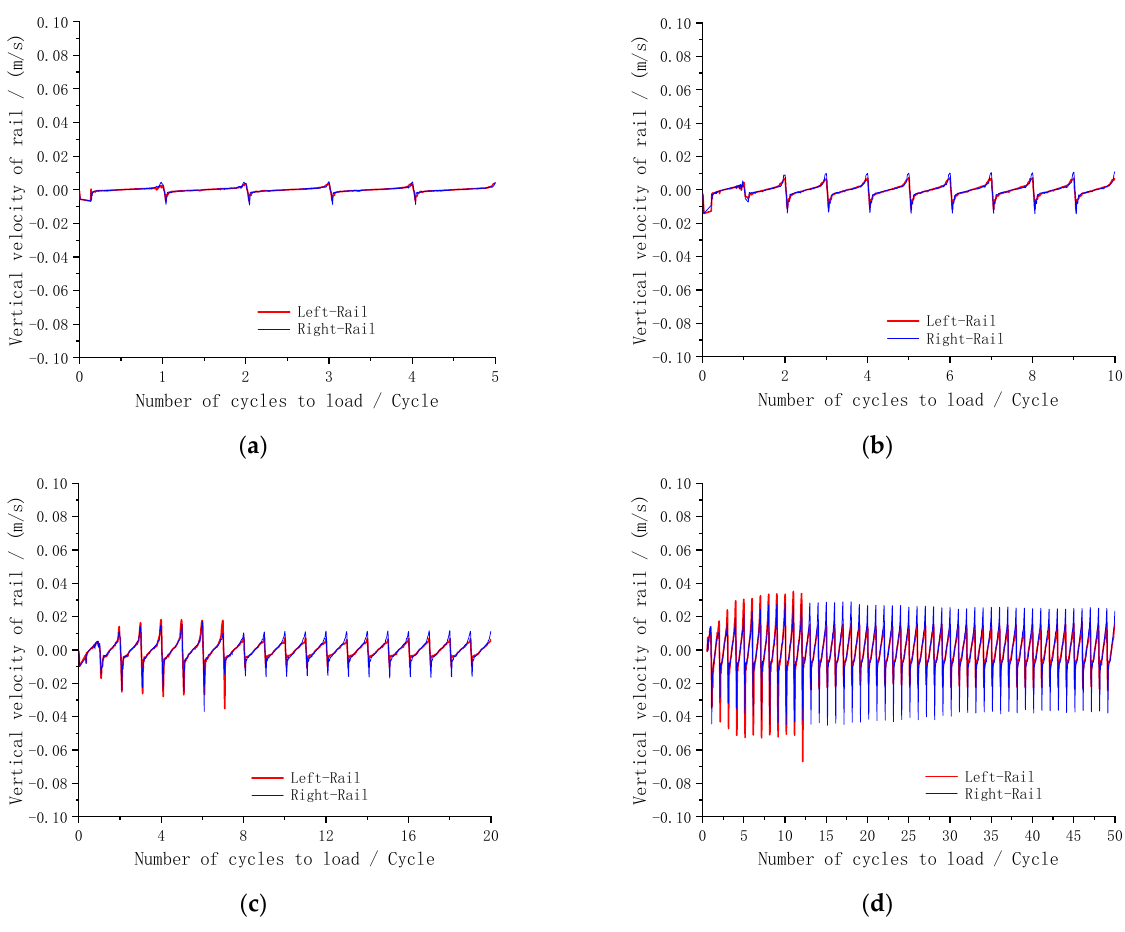
Figure 13. The vertical speed change curve of the rail. ( a ) 5 Hz. ( b ) 10 Hz. ( c ) 20 Hz. ( d ) 50 Hz. As shown in Figure 13, it can be seen that when the loading frequency was 5 Hz, the maximum speed of the left and right rails was approximately 0.01 m/s; the maximum rail speed corresponding to a 10 Hz loading frequency was approximately 0.015 m/s; the maximum speed of the left and right rails corresponding to a 20 Hz loading frequency was approximately 0.03 m/s; and the maximum rail speed was 0.04 m/s at a loading frequency of 50 Hz. The velocity changes of the left and right strand rails were similar, with periodic variation with the cyclic load, and the velocity amplitude increased with increasing loading frequency.